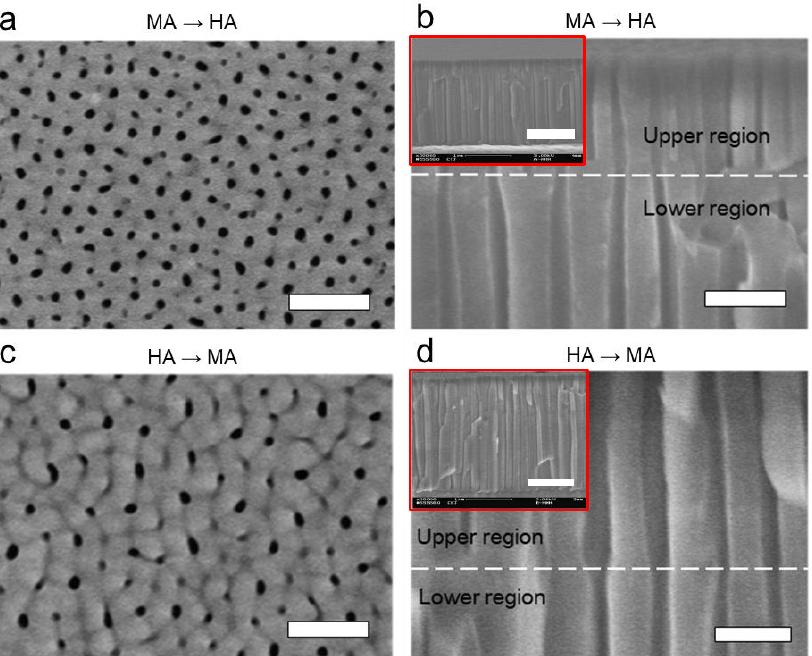
Figure 3. SEM images of the nanoporous alumina layer formed on an electropolished smooth (no pre-patterning) aluminum substrate, as a result of the stepwise anodizing process with the modulated anodizing voltage. ( a , b ) Top and cross-sectional views of the nanoporous alumina layer formed by MA (40 V, 30 min) followed by HA (100 V, 0.5 min). ( c , d ) Top and cross-sectional views of the nanoporous alumina layer formed by HA (100 V, 0.5 min) followed by MA (40 V, 30 min). The scale bar in each image represents 200 nm (1 μm in insets).